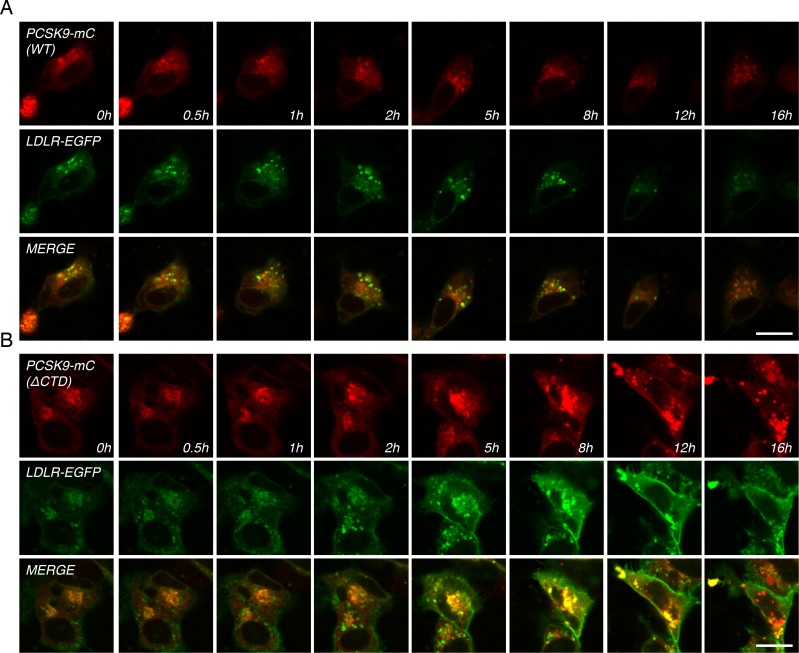
Live-cell imaging of WT PCSK9, PCSK9-ΔCTD-mC and LDLR-EGFP trafficking.HepG2 cells were co-transfected with LDLR-EGFP together with (A) WT PCSK9-mC (see S3 Video) or (B) WT PCSK9-ΔCTD (see S4 Video). Images were extracted from confocal microscopy time-lapse movies. Data are representative of at least three independent experiments. Scale bar, 20 μm.